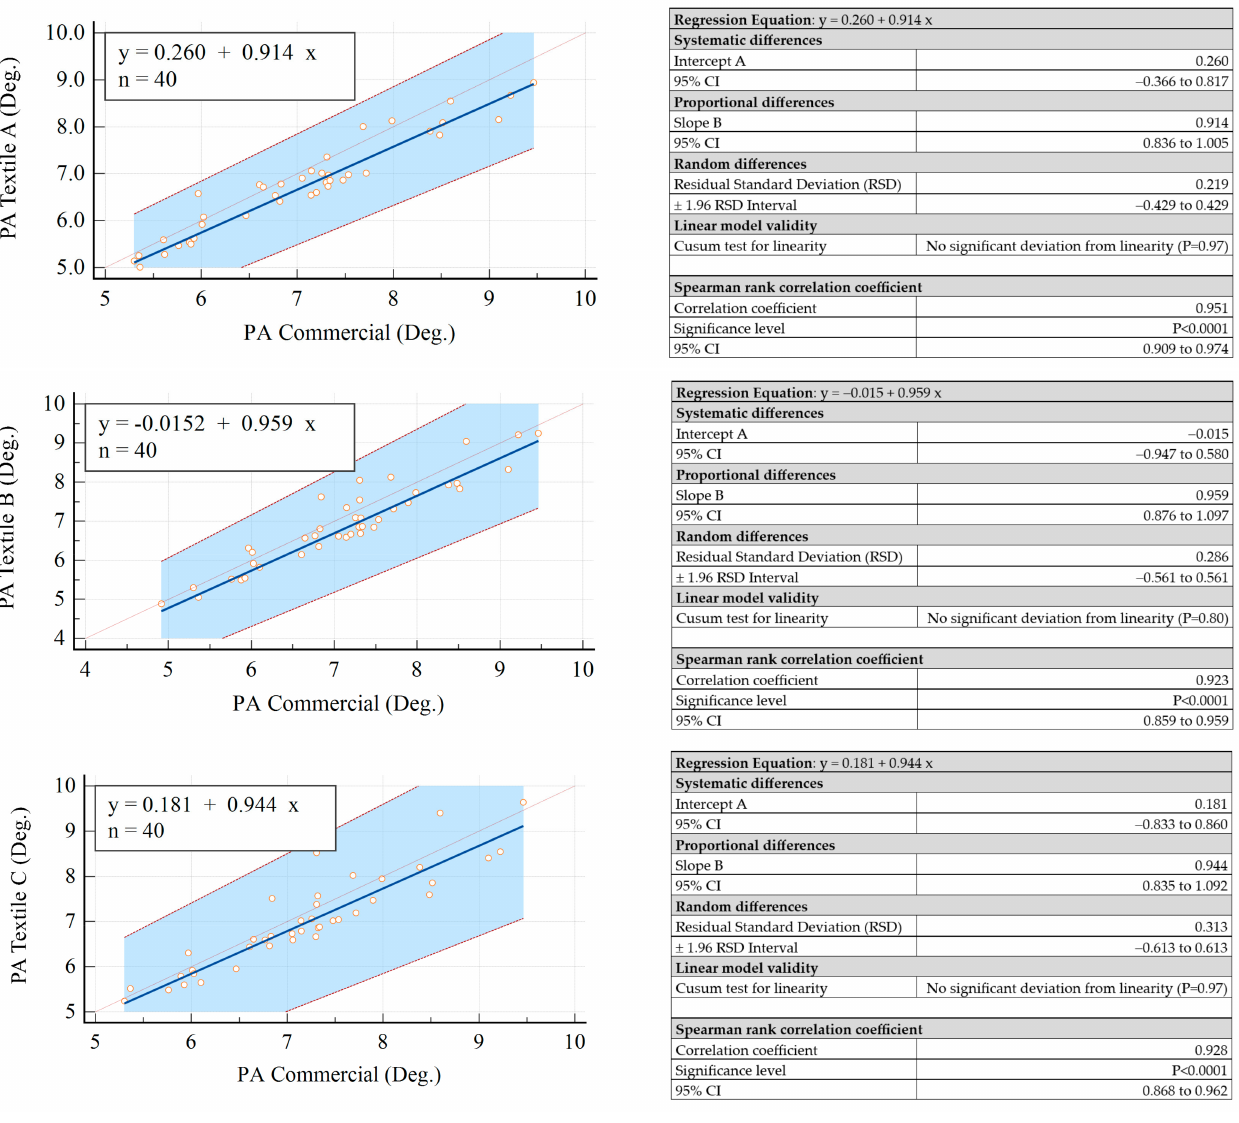
Figure 6. Passing–Bablok regression analysis results obtained for PA. The thin dotted line is the line for identity (y = x) while the thick blue line is the line for best fit. The red dashed lines indicate the 95% confidence